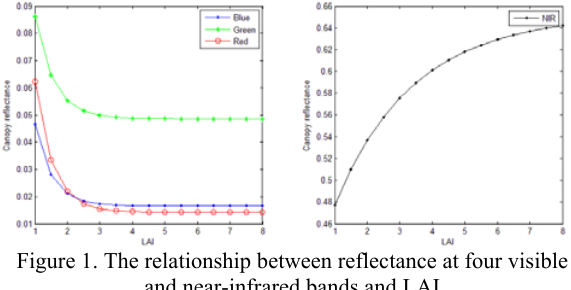
Figure 1. The relationship between reflectance at four visible and near-infrared bands and LAI